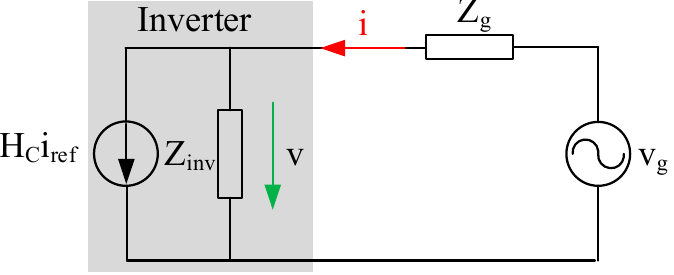
Figure 4. The equivalent circuit diagram of the inverter-grid system.